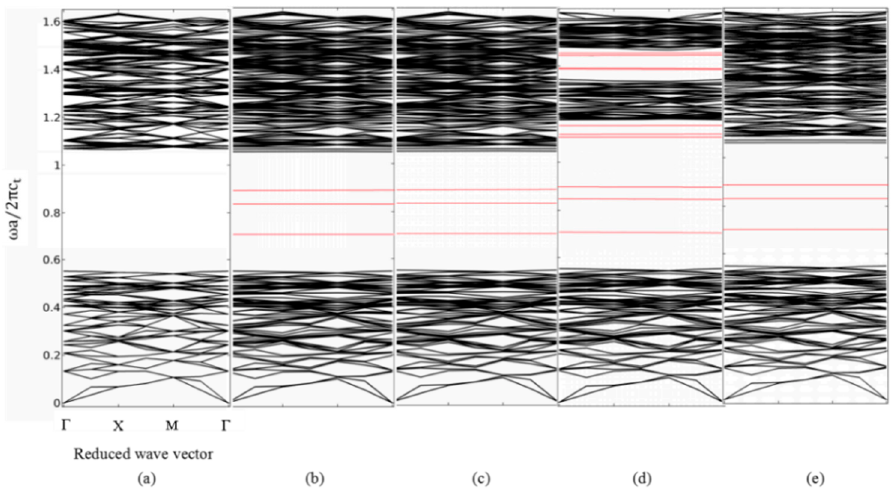
σ = 0 MPa, H = 0 kOe. z z